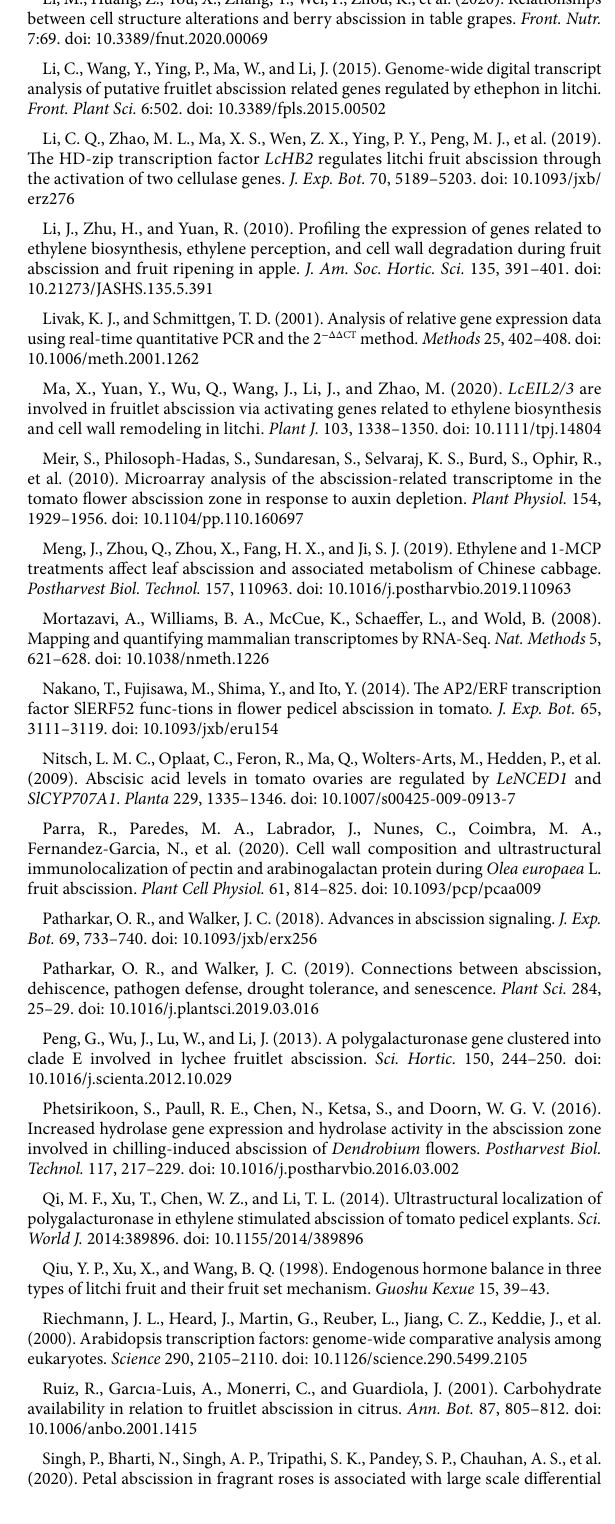
crabapple from August to November. Fruit abscission fell off completely in October (B) . The location of fruit-retention cultivars and the location of fruit-abscission